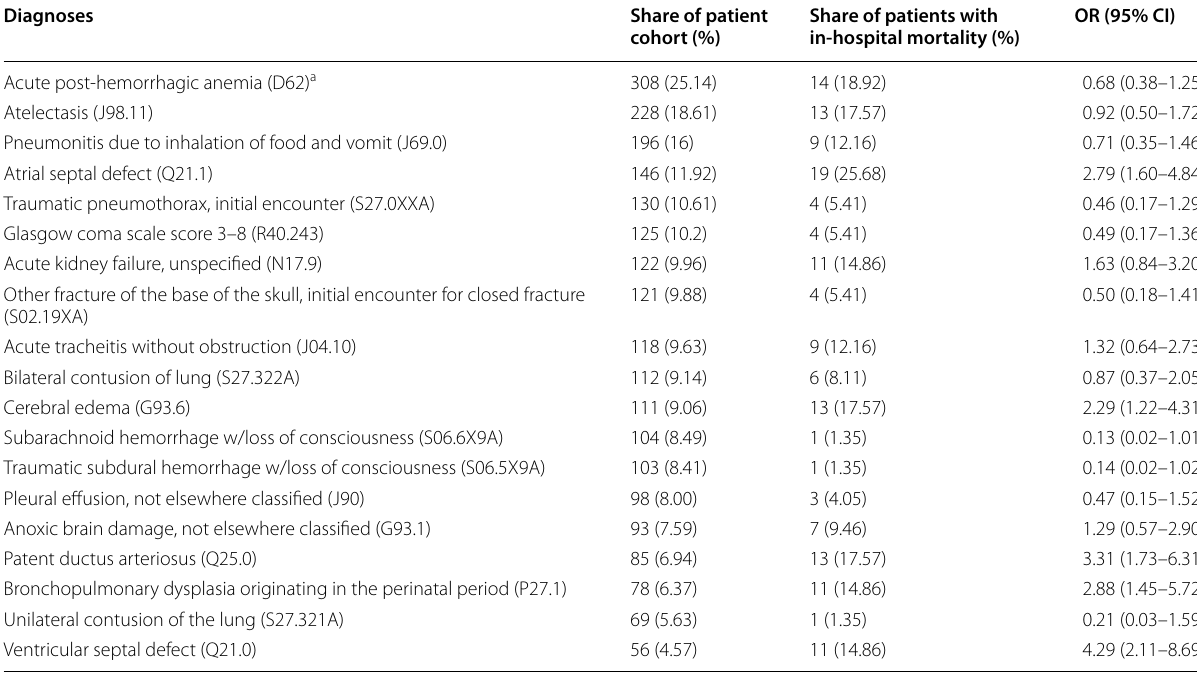
Table 4 Prevalence of comorbidities in PT patients and their association with in-hospital mortality using OR